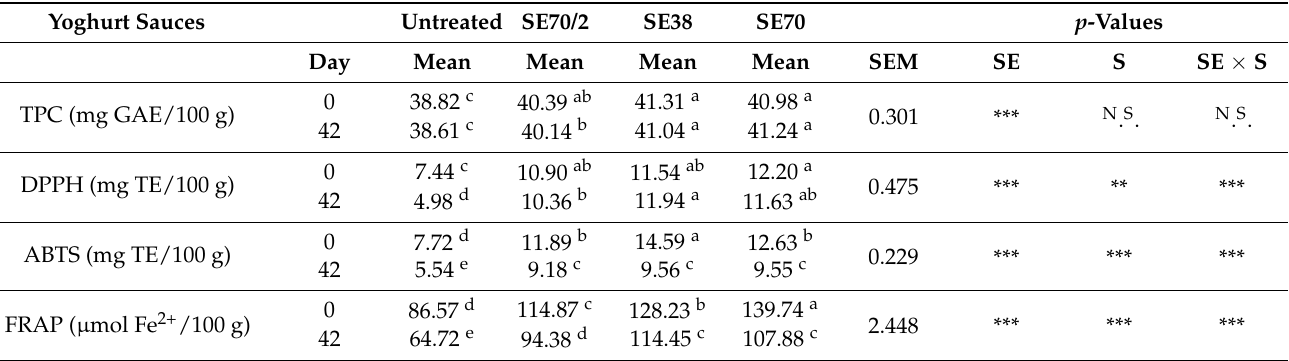
Table 4. Antioxidant capacity of yoghurt sauces enriched with sage extracts (SE70/2, SE38, and SE70) and kept at 4 ◦ C for 42 days.